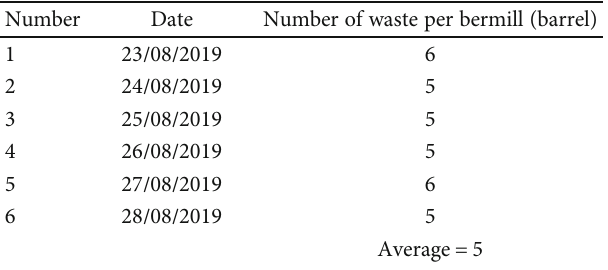
Table 3: Recorded sample of food waste per day for six consecutive days at campus 2.